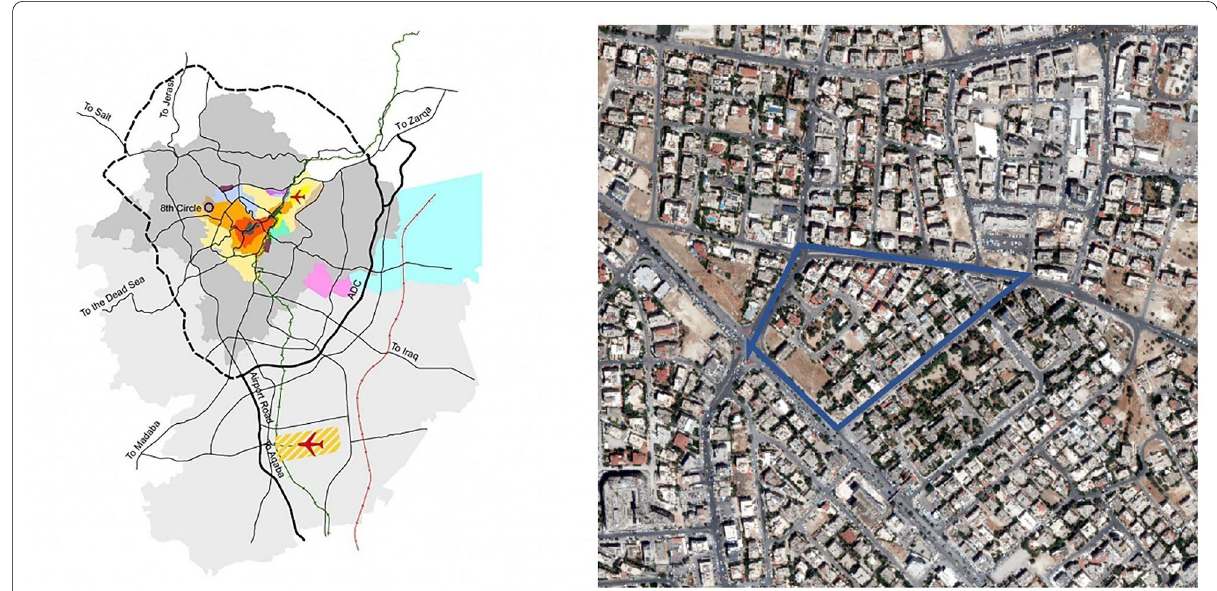
Fig. 3 The location of Dahiyat Al-Hussein relative to the center of Amman (left), and neighborhood form